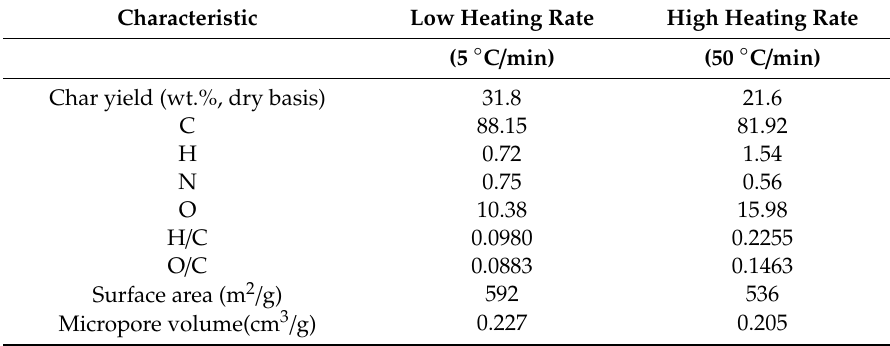
Table 4. The biochar yields, elemental analysis, surface area and micropore volume for walnut shell